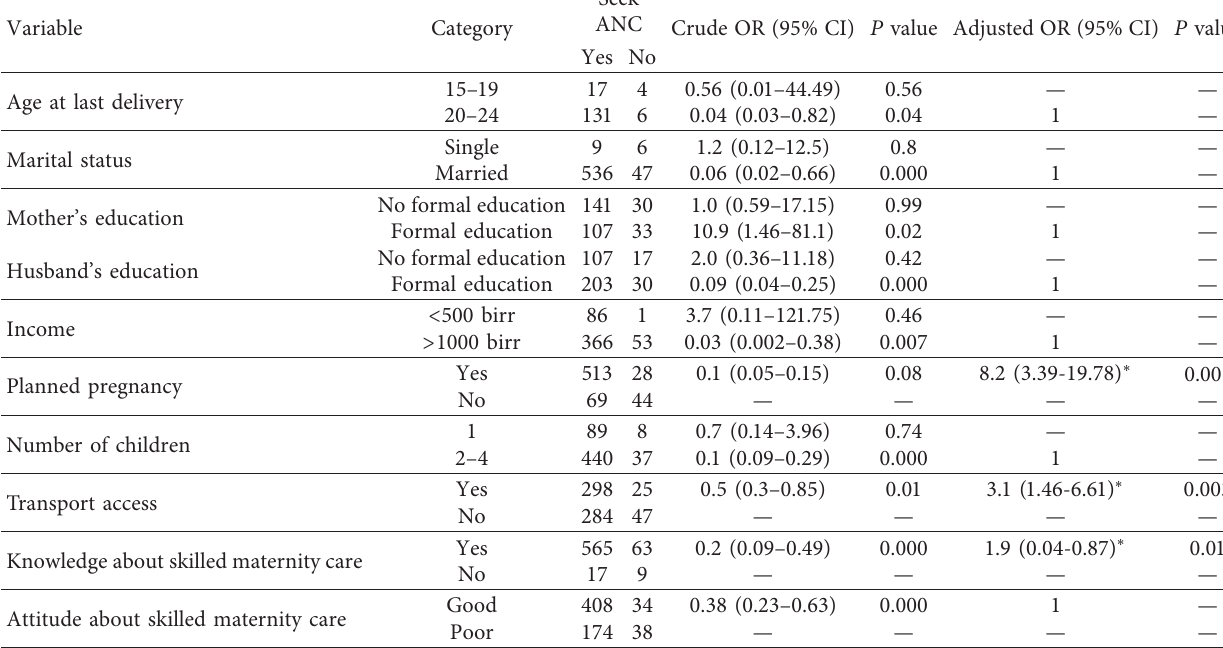
Table 5: Binary logistic regression model to examine the association of antenatal care services among study